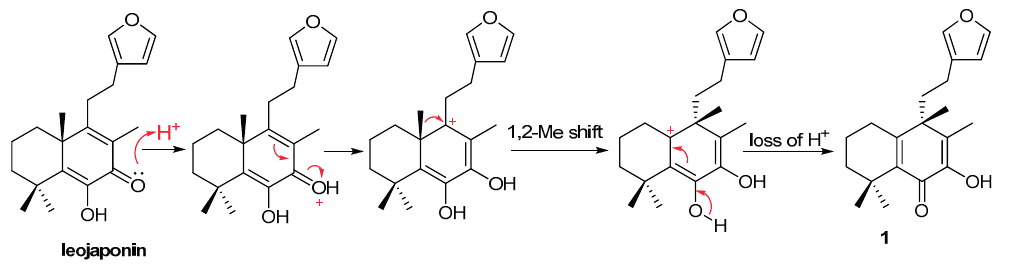
Figure 5. Proposed formation of 1 from leojaponin via 1,2-Me